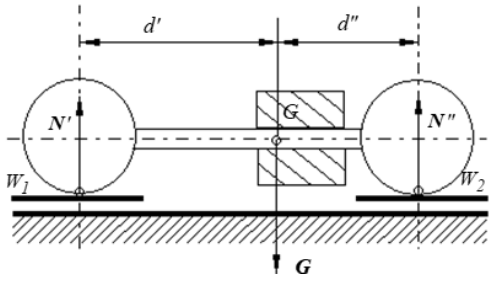
beam on two supports. From the moment equations applied for the free body diagram, the values of d ’ and d ”, characterizing the position of G , are obtained. The outer diameter of the cylindrical part must be noticeably smaller than the diameter of the spheres because only the balls should be in contact with the inclined plane. Figure 4. The rotor on the inclined plane and attached coordinate systems. Figure 4. The rotor on the inclined plane and attached coordinate systems.